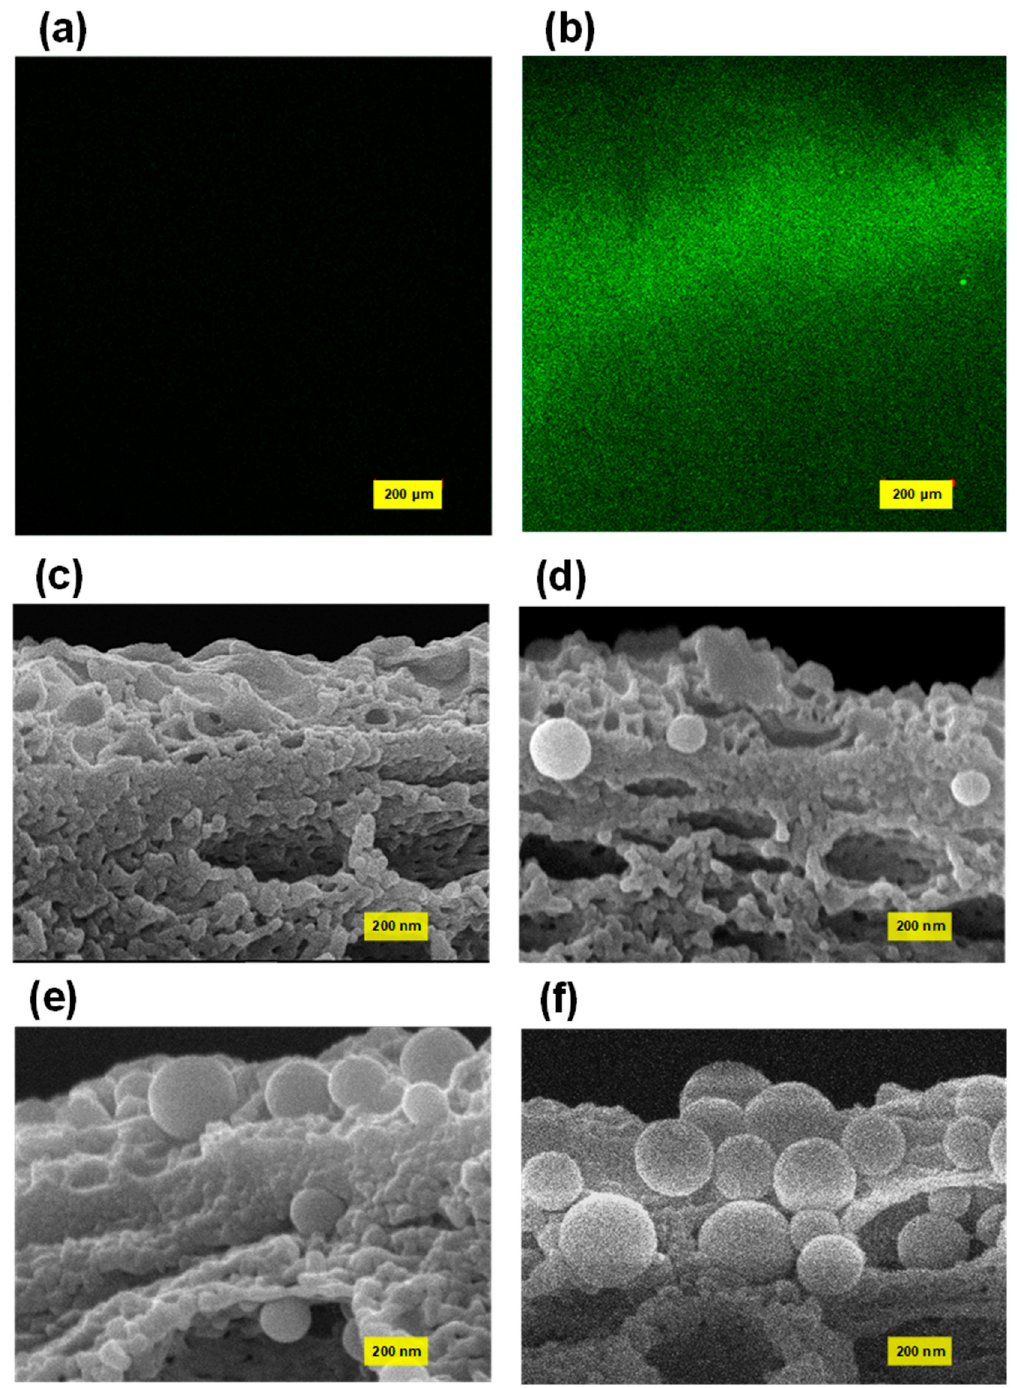
Figure 1. Fluorescence image of ( a ) the PSf support after being soaked with MPD solution and ( b ) the PSf support after being soaked with MPD solution containing fluorescently labelled proteoliposomes. Cross-sectional SEM images of ( c ) ABM-0, ( d ) ABM-8w, ( e ) ABM-16w, ( f ) ABM-32w. All membrane samples for SEM imaging were collected after the filtra- tion performance